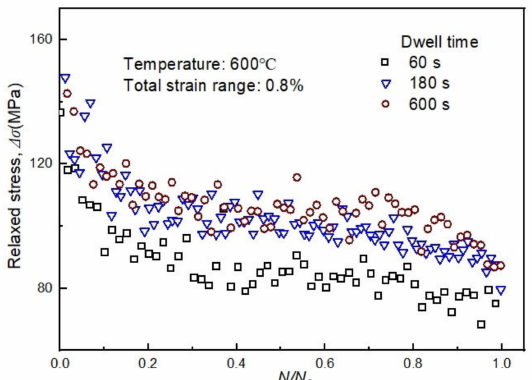
Figure 5. The evolution of relaxed stress at di ff erent dwell times.